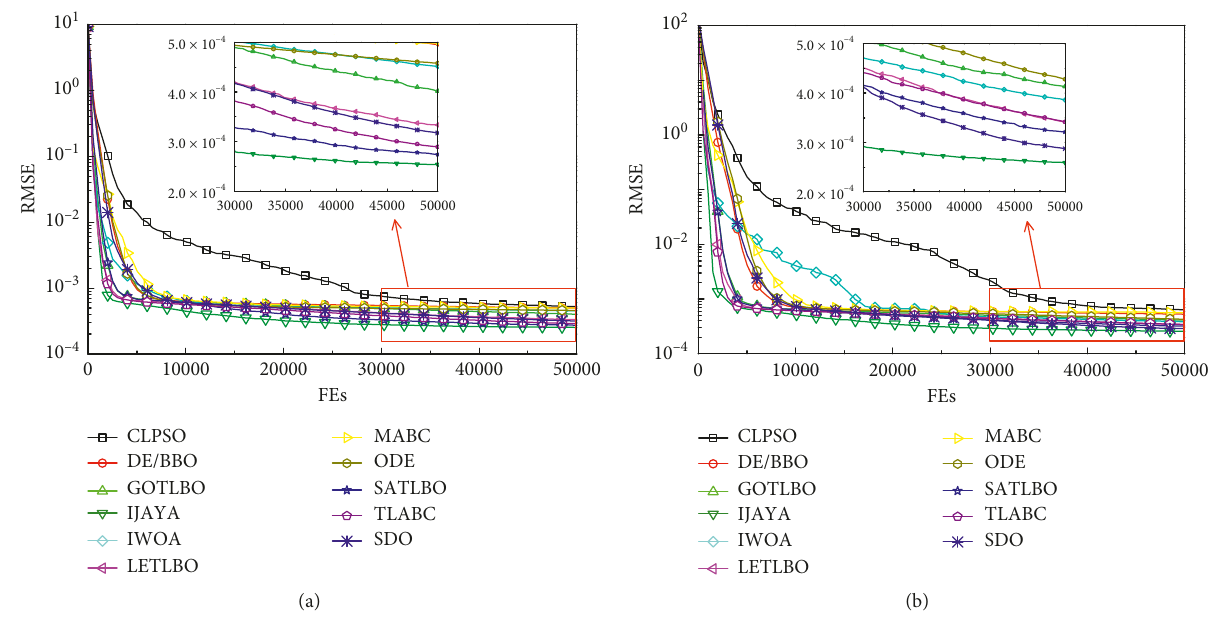
Figure 7: Convergence curves for the PVM 752 GaAs thin film cell. (a) SDM; (b) DDM. Table 7: Extracted value for the parameters of PVM 752 GaAs thin film cell by SDO.